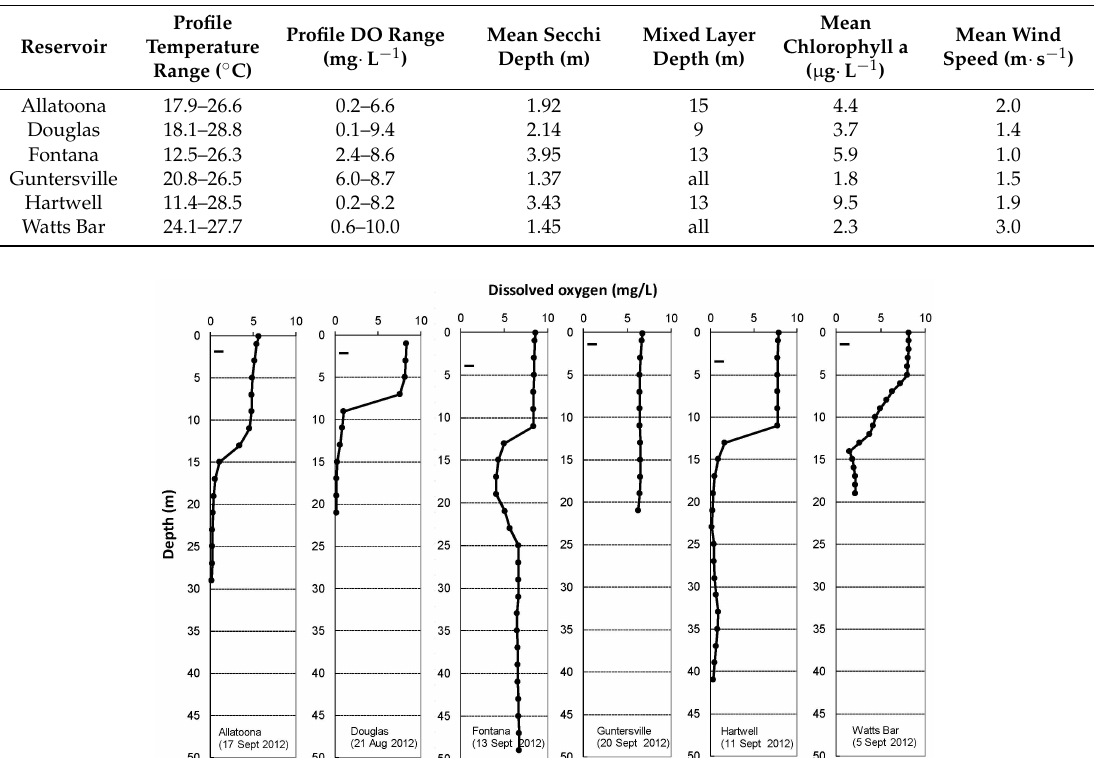
Figure 2. Vertical profiles of dissolved oxygen (mg ¨ L ´ 1 ) for six southeastern U.S. reservoirs during synoptic sampling in late summer 2012. The single dash represents the Secchi disk depth. Data presented are from the deepest main channel site at each